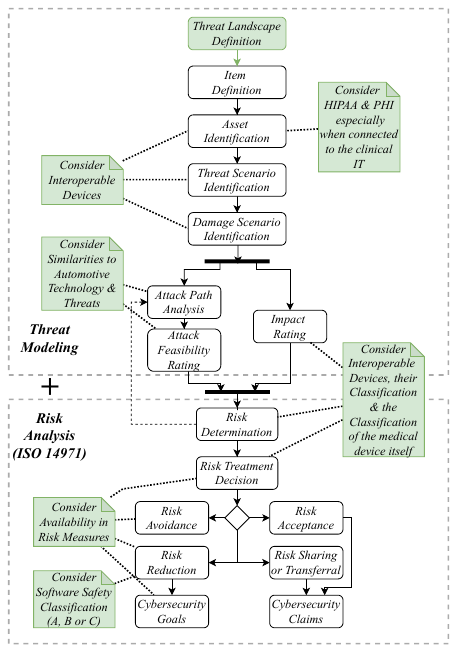
Figure 4. Heavens 2.0 workflow [13] considering a medical context (Section